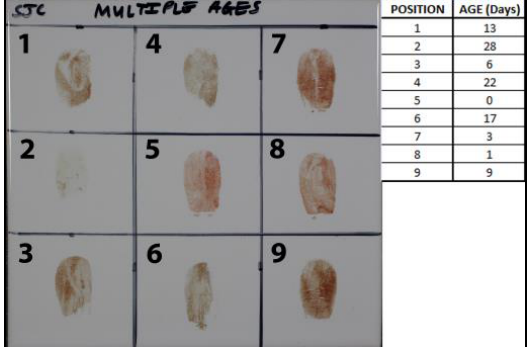
Figure 4. Nine blood-stained fingerprints from 0 to 28 days old.